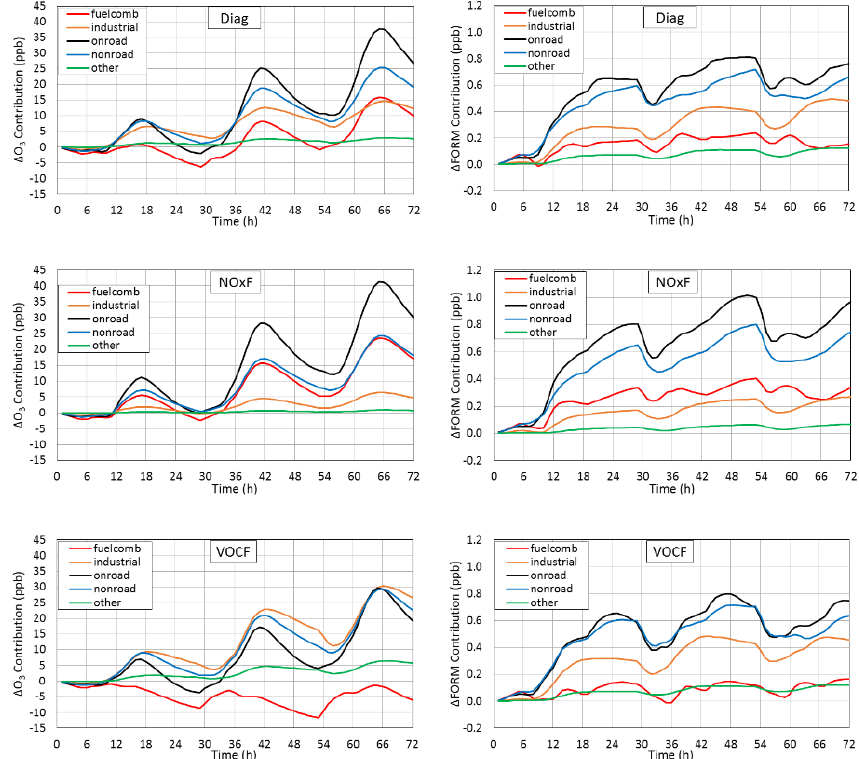
Figure 5. Apportionment of the anthropogenic O 3 increment (left) and the FORM increment (right) to sources using the Diag, NOxF, and VOCF emission-control